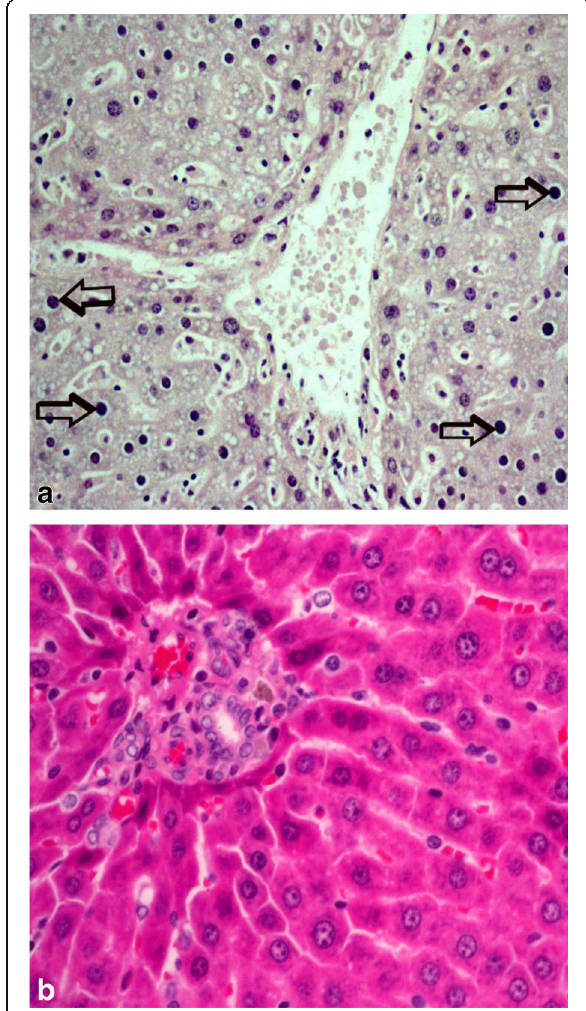
Fig. 9 Histological section of the liver from mice that received 2000 mg/kg, 8 hourly intervals but died on 2nd day of treatment. There is a marked cytoplasmic vacuolation of hepatocytes, some pyknotic hepatocytes ( black arrows) and Küpffer cell hyperplasia in ( a ). Section ( b ) is for comparison, has normal hepatocytes and cellularity. Magnifications, ( a & b ) 400